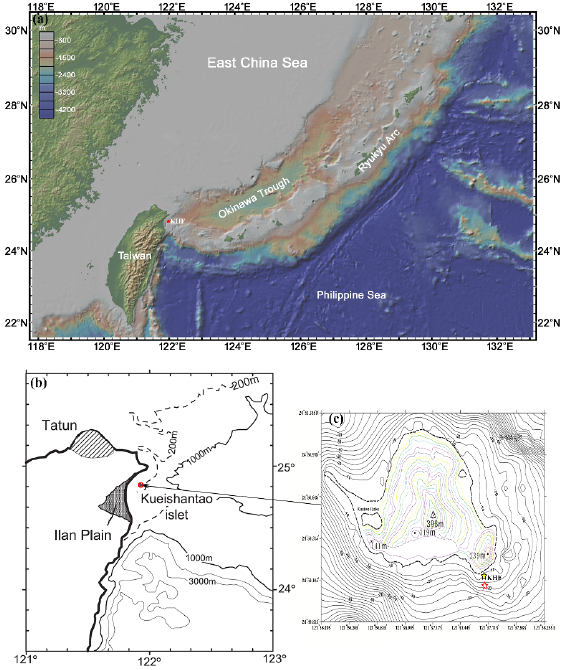
Figure 1. ( a ) The bathymetric map of Taiwan and the Okinawa Trough (based on [41]). ( b ) The tectonic map with the location of Kueishantao island (from [42]). ( c ) The location of the yellow spring (yellow star, 108 °C) and white spring (red star, 51 °C) in the Kueishantao hydrothermal field (based on [41]). There are two types of vents, “yellow spring” (78~116 °C) and “white spring” (30~65 °C) [42]. The yellow spring fluids are characterized by very low pH (~1.52) and a wide range of chemical compositions. The white spring fluids have a relatively low content of methane, iron and copper [42]. The temperature of the vent fluids varied with tides and reached the maximum temperature approximately 3.5 h after each high tide [42–44]. The Ca, Mg and K are significantly correlated with each other, indicating the same source of seawater [45]. The gas component is mainly CO 2 , followed by N 2 , CH 4 and H 2 S [46]. 3. Sampling and Methods 3.1. Sample Collection On 31 May 2011, the samples of hydrothermal fluids and plumes were collected from the Kueishantao hydrothermal field by divers (Table 1, Figure 1). Four liter Pyrex bottles were used to sample the hydrothermal fluids at and in the vent. Two-valve polyethylene tubes were also employed to sample the fluids in order to assess the reliability of the data gained by the Pyrex bottles. The hydrothermal plume was sampled in 1 L Nalgene poly- propylene bottles at approximately 2, 5 and 7 m below sea level above the yellow spring vent (water depth, 7.2 m) and approximately 5, 10, 13 and 15 m below sea level above the white spring vent (water depth, 15.1 m). Shallow seawater was sampled at a depth of 10 m near Kueiwei to eliminate the effect of hydrothermal activity. The fluid fluxes and tem- peratures were determined in situ. Kuo [43] described in detail the methods of fluid col- lection and the measurement of temperature and flux in situ.